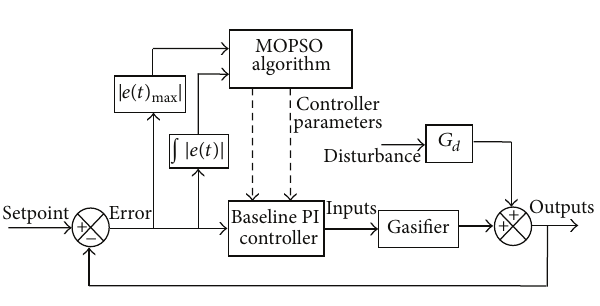
Figure 2: Block diagram of optimization